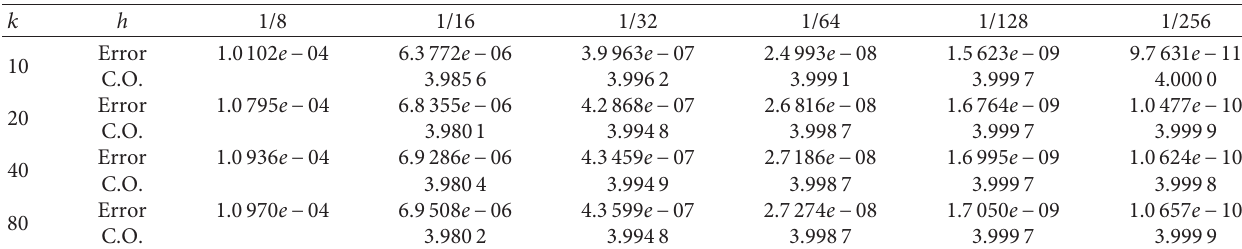
Figure 6: Illustration of the MIB iterative procedure for determining the function values on fictitious points in the diagonal area. (a) f Table 2: Numerical convergence and error of the new 21-point difference scheme for Example